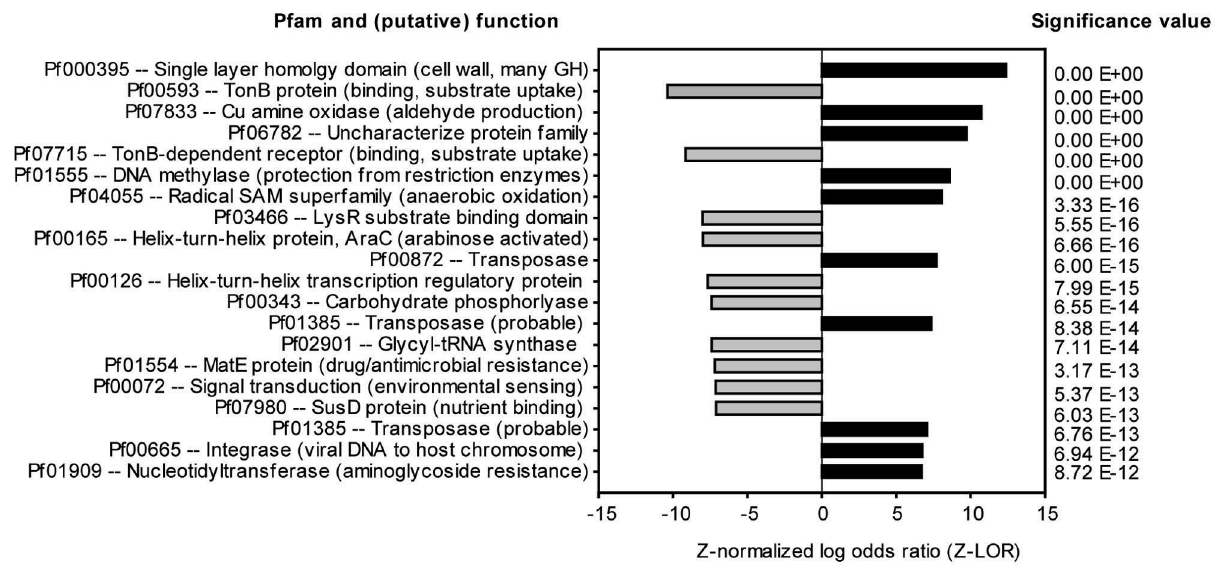
Figure 2. Pfams significantly enriched in the thermophilic (55 u C, black) and mesophilic (40 u C, gray) metagenomes. Negative Z- normalized log odds ratio values indicate Pfams that were enriched in the mesophilic community, and a complete list of the Pfams that were found to be significantly different between the two communities is provided in Table S3.